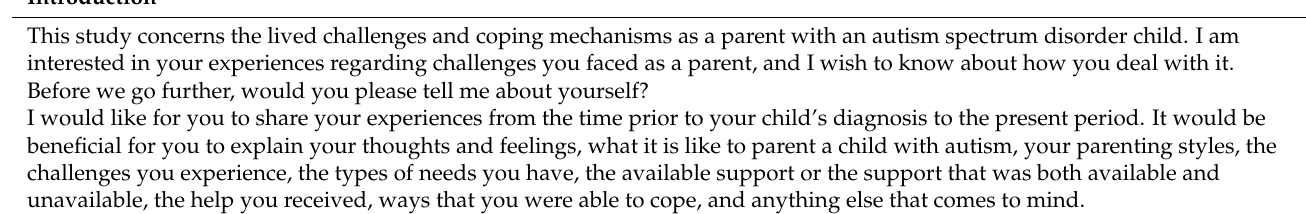
Table 2. The semi-structured interview